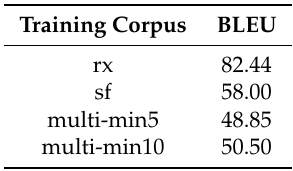
Table 3. BLEU scores from training on three